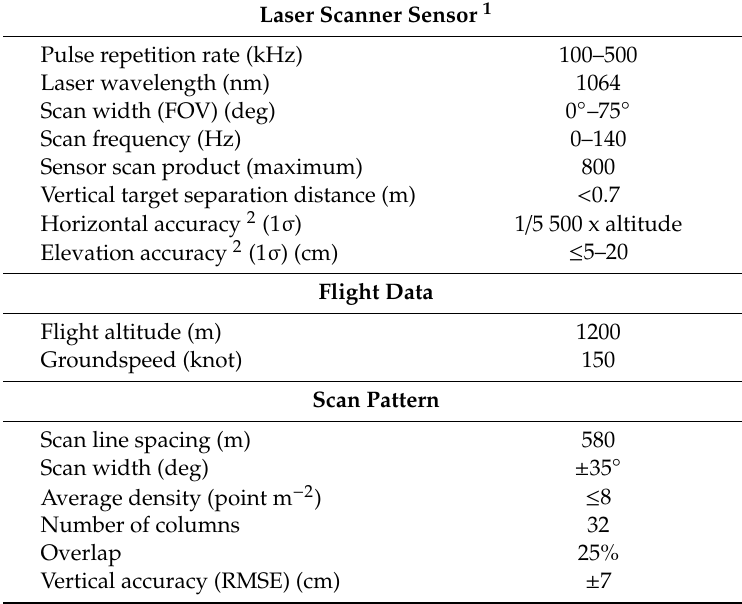
Table 1. Technical specifications of Optech Pegasus HA-500 laser sensor and flight